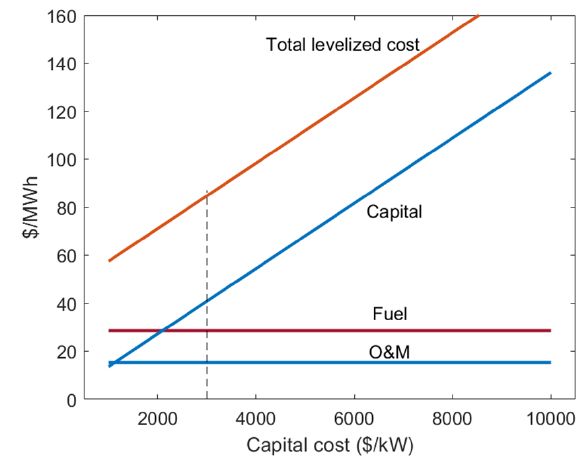
Figure 12. NB levelized electricity costs vs. capital cost.